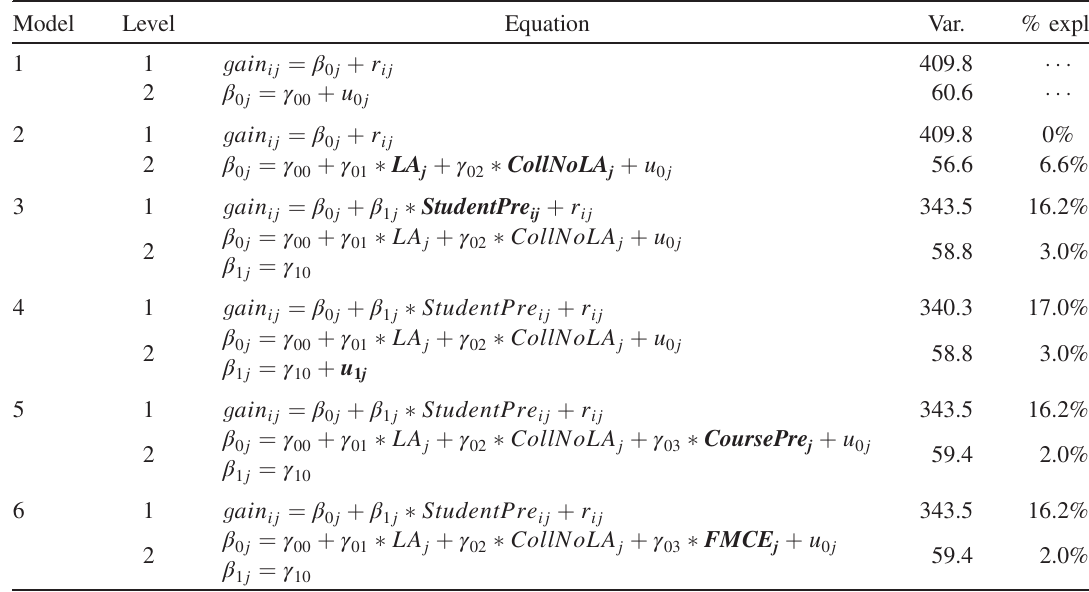
TABLE IV. Model development with final estimation of variance components (Var.) and the percent variance explained (% expl.) compared to model 1, the unconditional model. The inclusion of additional variables (shown in bold) in models 4, 5, and 6 failed to improve the percent explained variance by more than 1% at either level. We used model 3 to compare MLR and